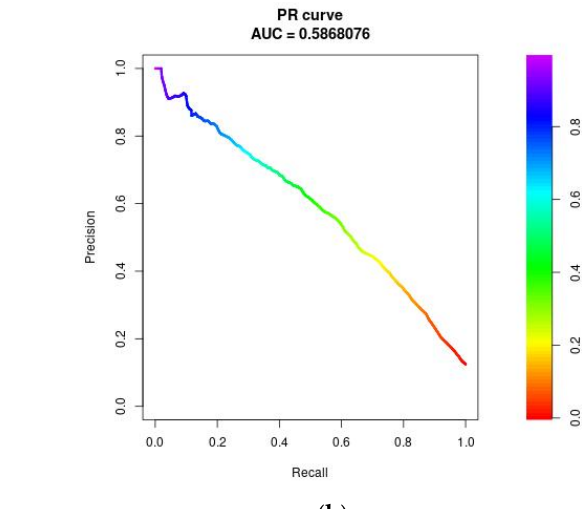
Figure 1. Performance evaluation for LASSO ( a ) Receiver Operating Characteristic (ROC) curve; ( b ) Precision-Recall (PR) curve. AUC: Area under the curve